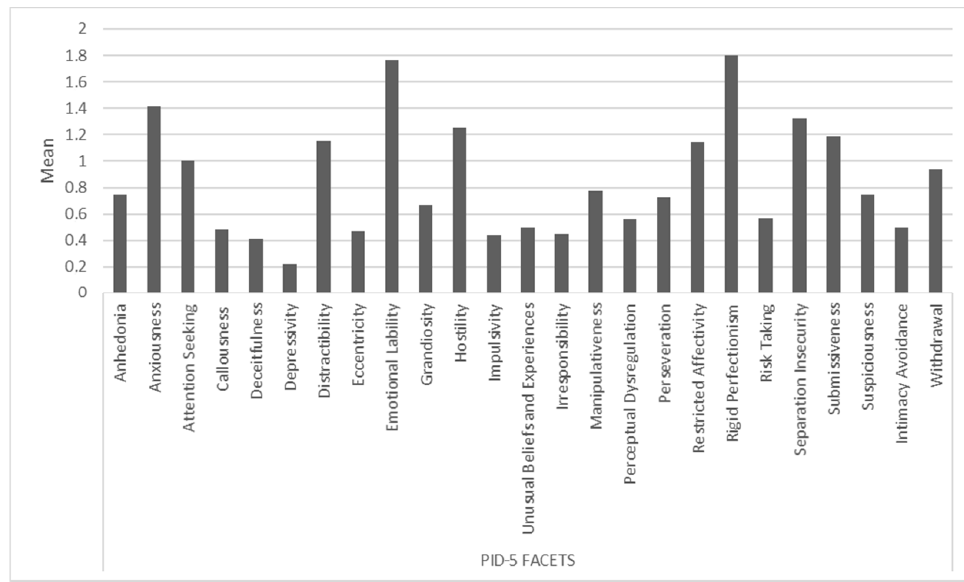
Figure 1. Representation of distribution of sub-items of PID-5 facets.